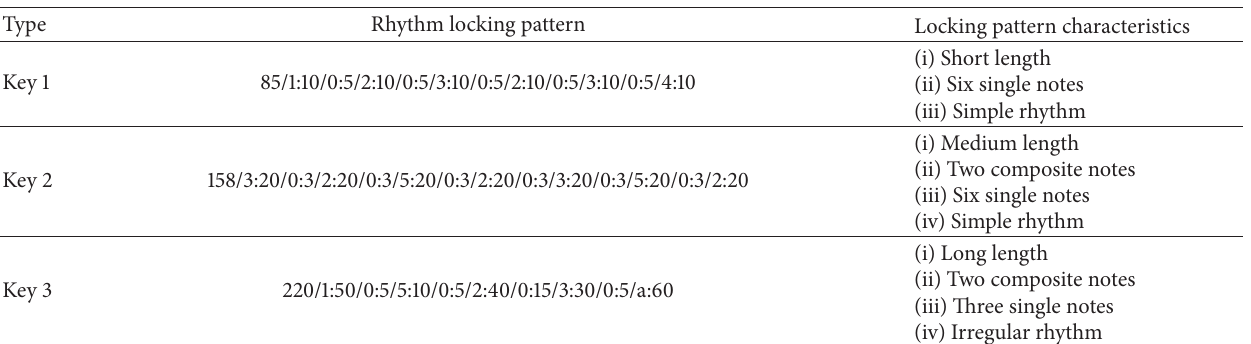
Figure 8: Rhythm pattern setup process in the RLS. Table 4: Three types of the standard key based on key length.